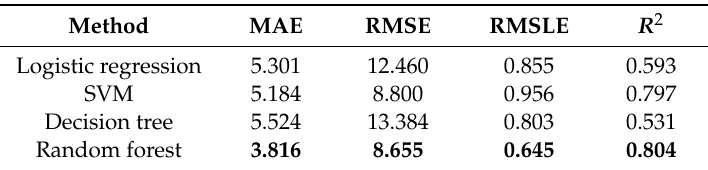
Table 2. Comparisons of performance evaluation.